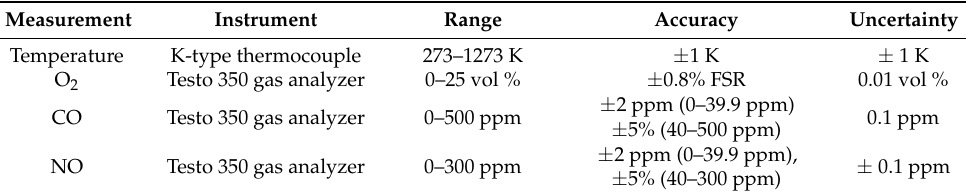
Table 1. Specifications of the instrument and uncertainty.